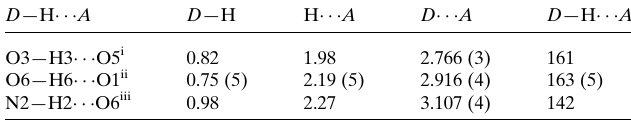
Table 1 Hydrogen-bond geometry (A˚ , (cid:3) ).